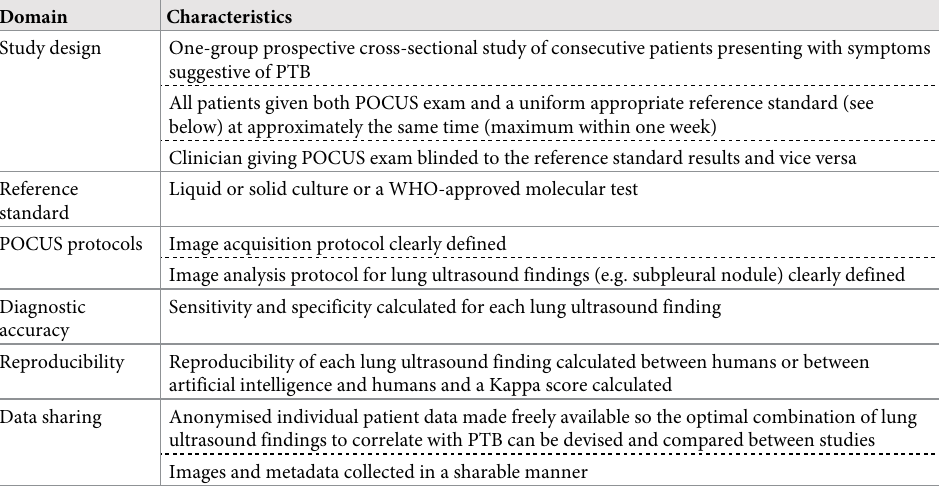
Table 8. Recommendations for the design of a diagnostic accuracy study of POCUS for PTB in adults.